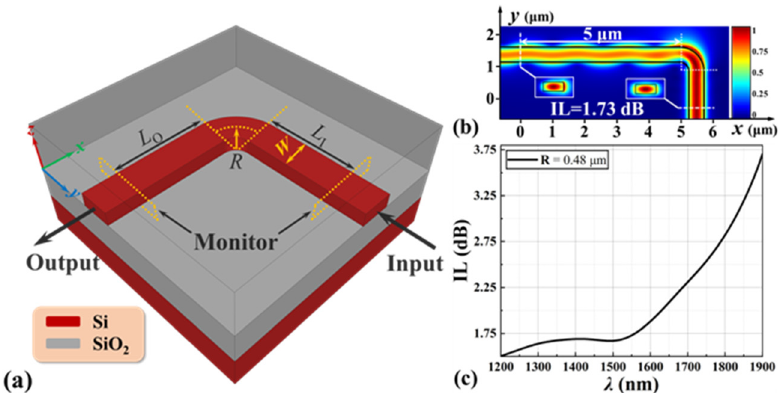
Figure 1. 90° direct silicon waveguide bend. ( a ) Device schematic. ( b ) Electric field evolution (| E |) through the direct waveguide bend with a radius of R = 0.48 μ m, where | E | stands for the norm of electric field. ( c ) Wavelength spectrum of IL for the device in a wavelength range from 1.2 μ m to 1.9 μ m.